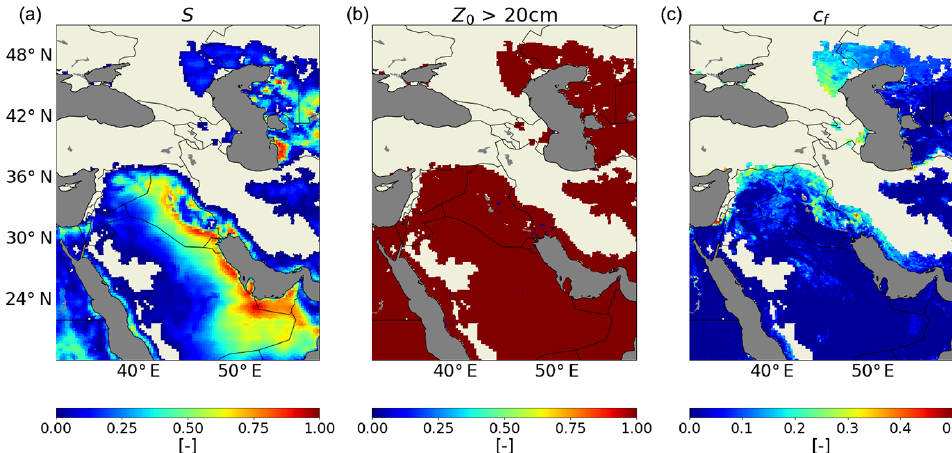
Figure 9. Relevant test domain terrain attributes, including source strength ( S , a ), roughness length greater than 20cm ( z 0 > 20cm, b ), and vegetation fraction ( c f , c ). Areas where S = 0 (i.e., areas identified as vegetated by AVHRR data) are masked in all plots to highlight attributes of grid cells capable of producing dust in the simulation. Areas of dark gray are water